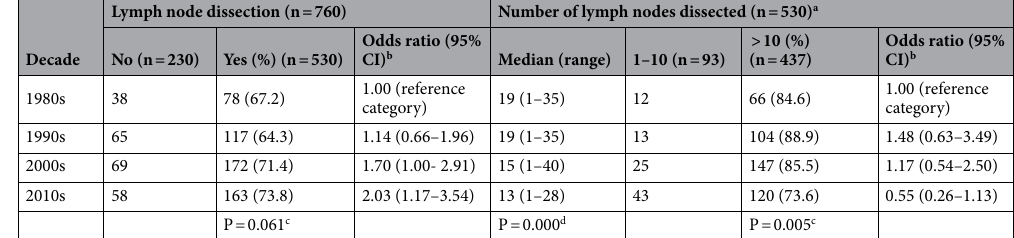
Table 1. Association of time period with the likelihood of lymph node dissection and the number of lymph nodes dissected in patients with vulvar squamous cell carcinoma living in northern Italy. a Analysis was restricted to patients undergoing lymph node dissection. b Simultaneously adjusted for patient age, tumour size, and disease location. c Chi-square test for trend. d Kruskal-Wallis test. CI, confidence